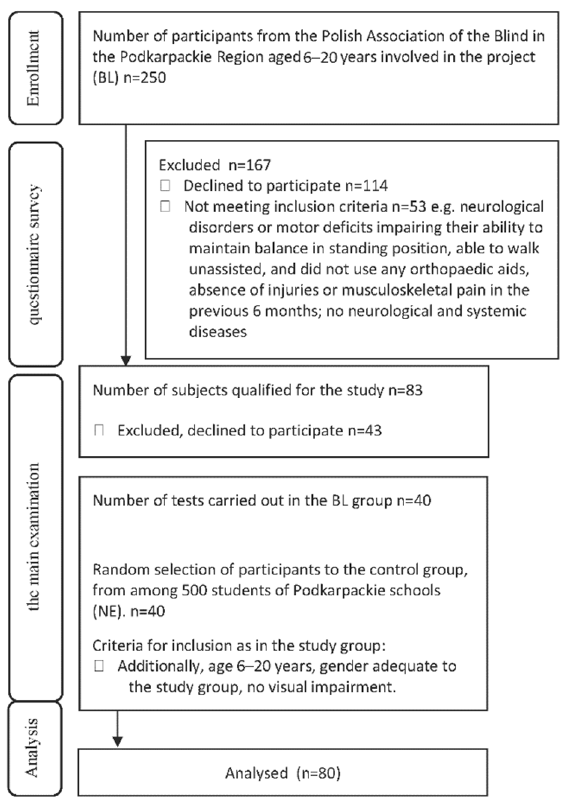
Figure 1. Flow Figure 1. Flow Diagram.